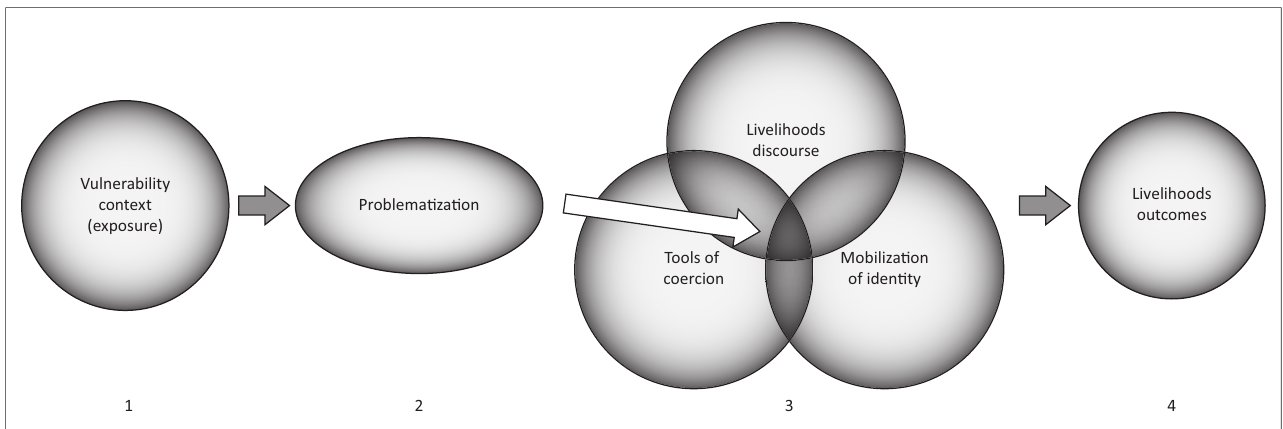
FIGURE 1: Conceptual map of the Livelihoods as Intimate Government approach.